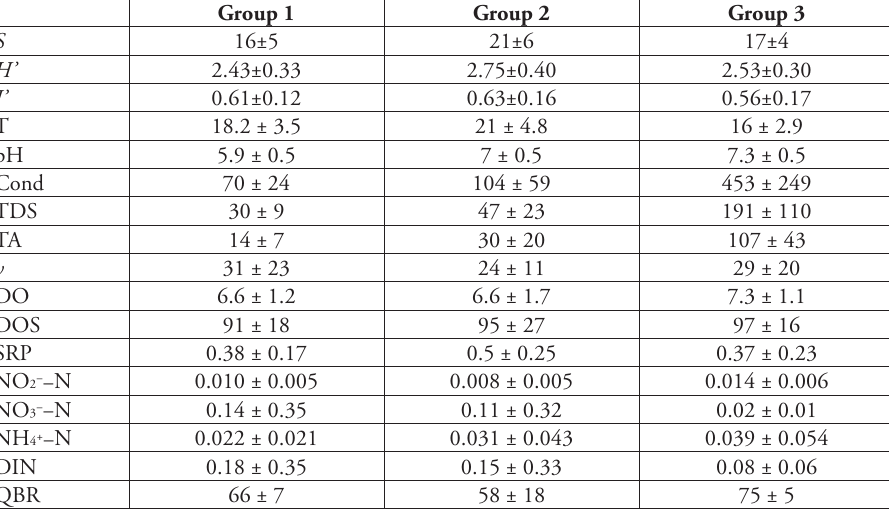
Table 3. Diversity indices and physical and chemical composition of the three groups visualized after the CCA. The mean value and standard deviation is provided for each variable. S = species richness; H’ = Shannon-Wiener diversity index; J’ = Pielou evenness index. For abbreviations and units of the physical and chemical variables refer to Table